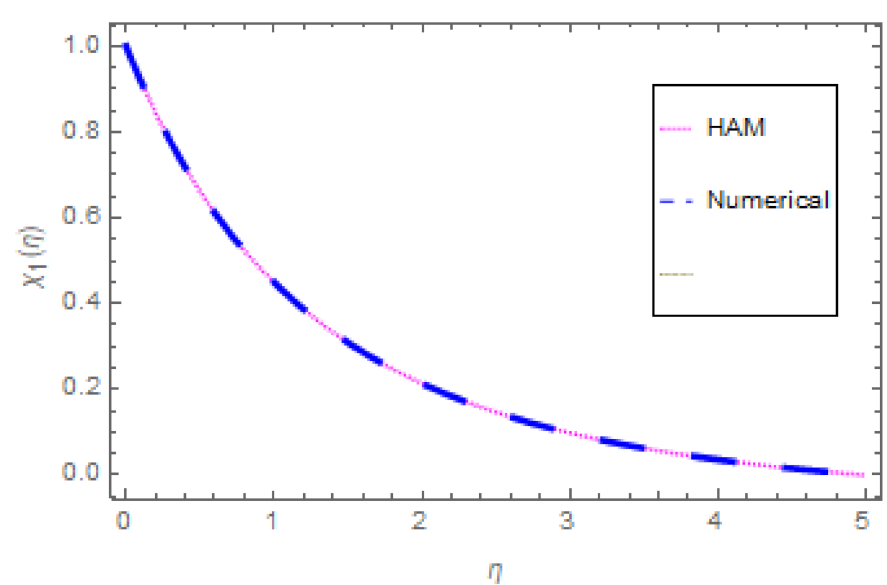
Figure 4. Comparison graph for concentration